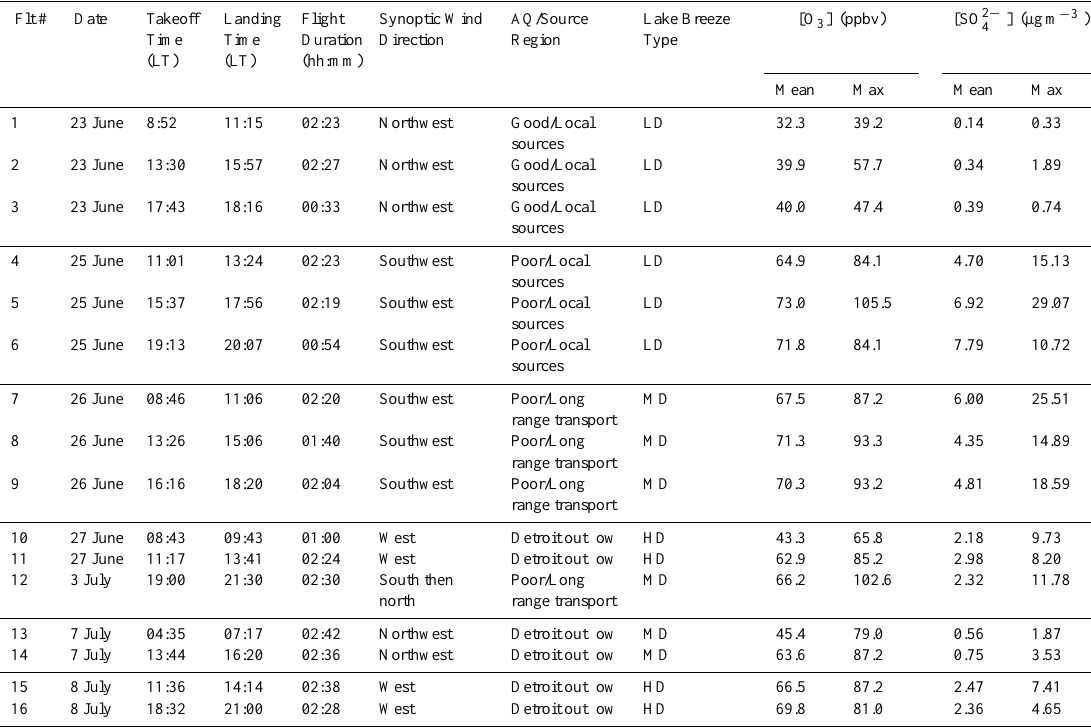
Table 1. Summary of Twin Otter flights showing the synoptic wind direction (based on back-trajectories analyses), an air quality descriptor (AQ), the lake breeze type (LD=Low Deformation; MD=Medium Deformation; HD=High Deformation; details in Sills et al., 2011), and O 3 and SO 2 − mean and maximum levels based on aircraft measurements. 4